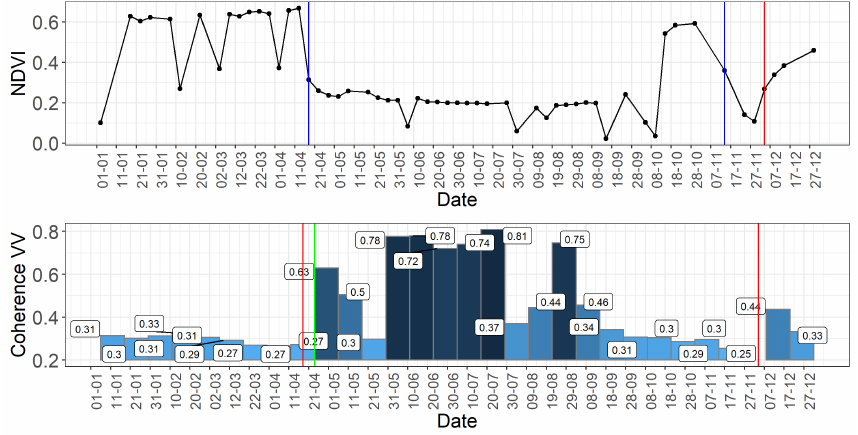
Figure 12. Example of false response of the optical algorithm due to cloudiness in November (cid = 450). Actual harvest dates (red lines): 18 April 2018 and 4 December 2018; harvest dates according to the optical algorithm (blue lines): 18 April 2018 and 14 November 2018; harvest date according to the SAR algorithm (green line): 24 April